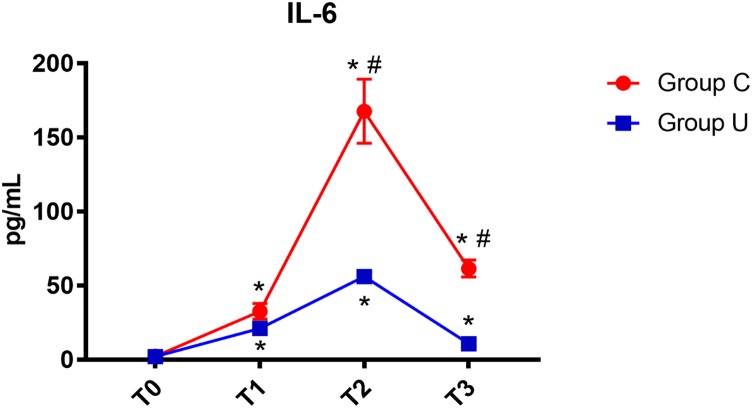
IL-6 concentrations over time. IL-6, interleukin-6; Group C, the control group; Group U, the ulinastatin group. ∗P < 0.05 from T0 in group C and group U (statistically significant), #P < 0.05 from group U (statistically significant). T0, = before skin incision, T1 = the end of operation, and T2 and T3 = 24 and 72 h postoperative.